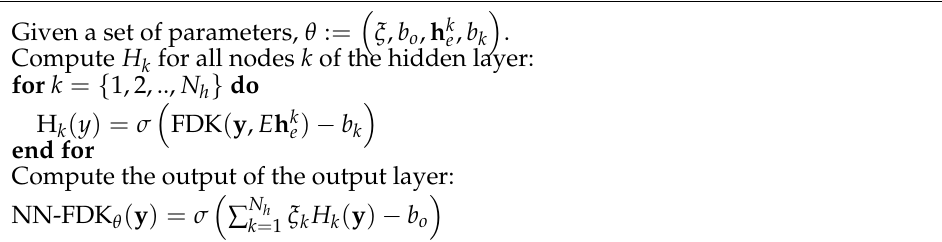
Algorithm 1 Neural Network Feldkamp–Davis–Kress (NN-FDK) reconstruction algorithm